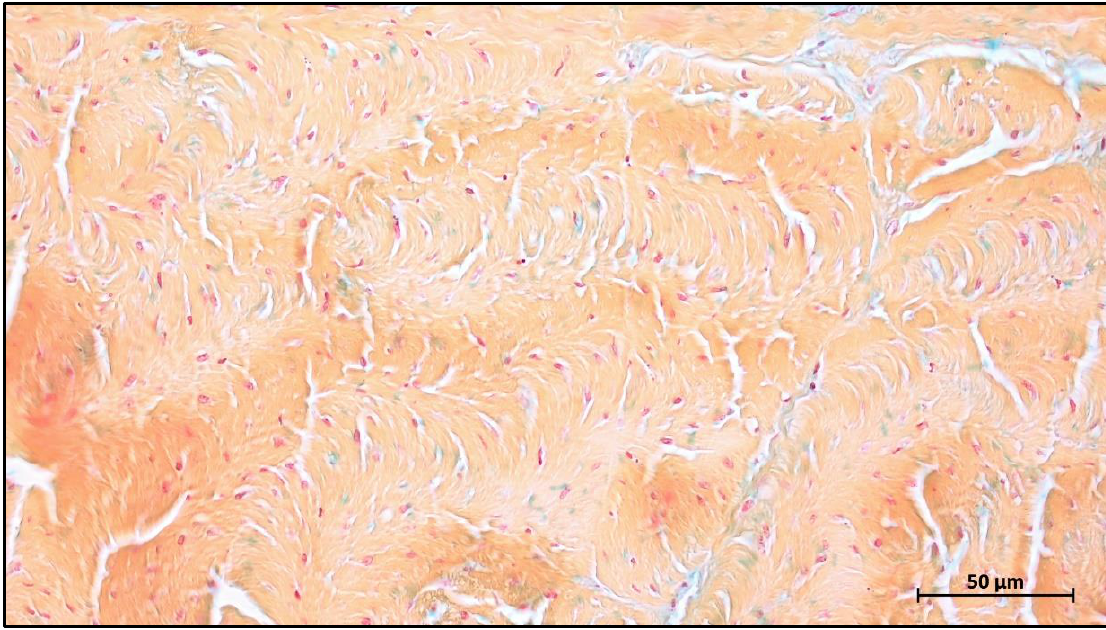
Figure 7. Representative histological image showing native porcine Archilles tendon tissue (prior to decellularization) with a high portion of collagen (yellow staining) and contained tendocytes (red staining) (Movat Pentachrome staining, 200× magnification, scalebar = 50 µm).